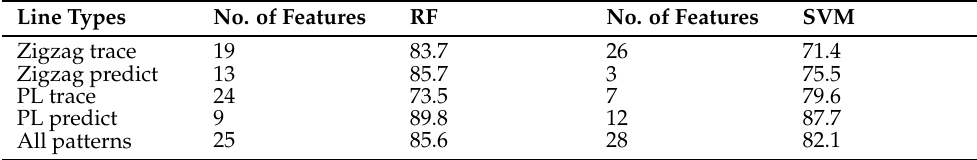
Table 8. Classification accuracy (in %) of RF and SVM for handwritten pattern